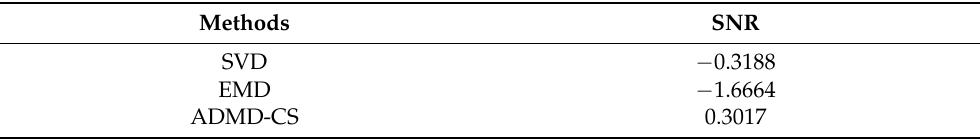
Table 4. SNR of recovered and original signals, after processing the simulation signal with different methods.